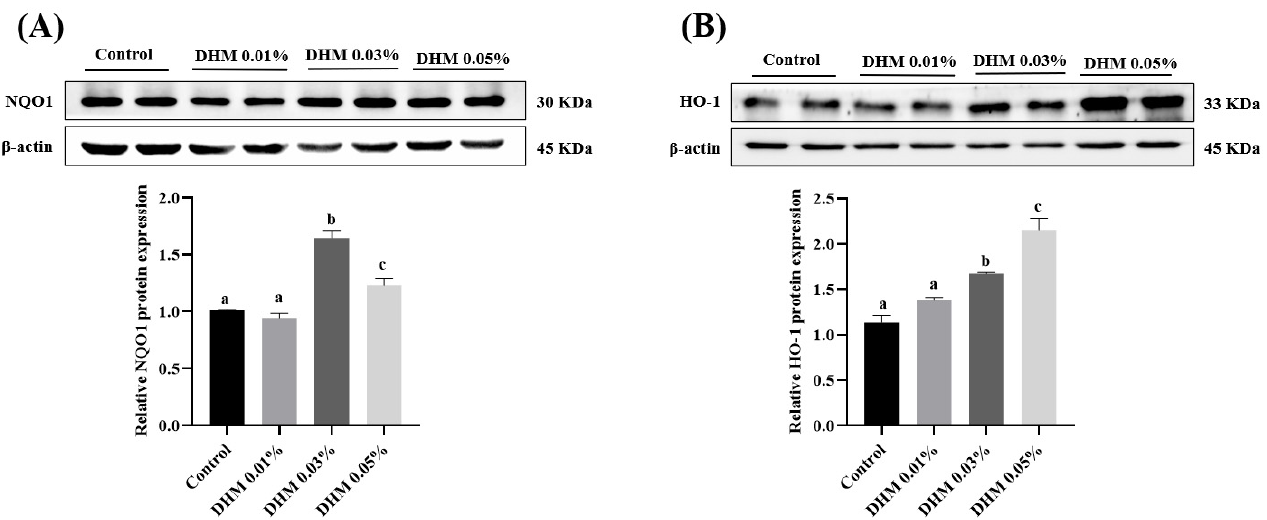
Table 1. Effects of dietary DHM supplementation on antioxidant indicators in jejunum mucosal of growing-finishing